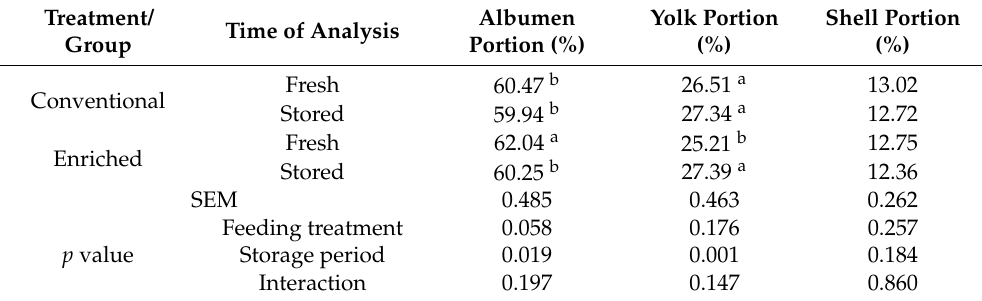
Table 3. Influence of feeding treatment and storage period on the portions of main parts in eggs.